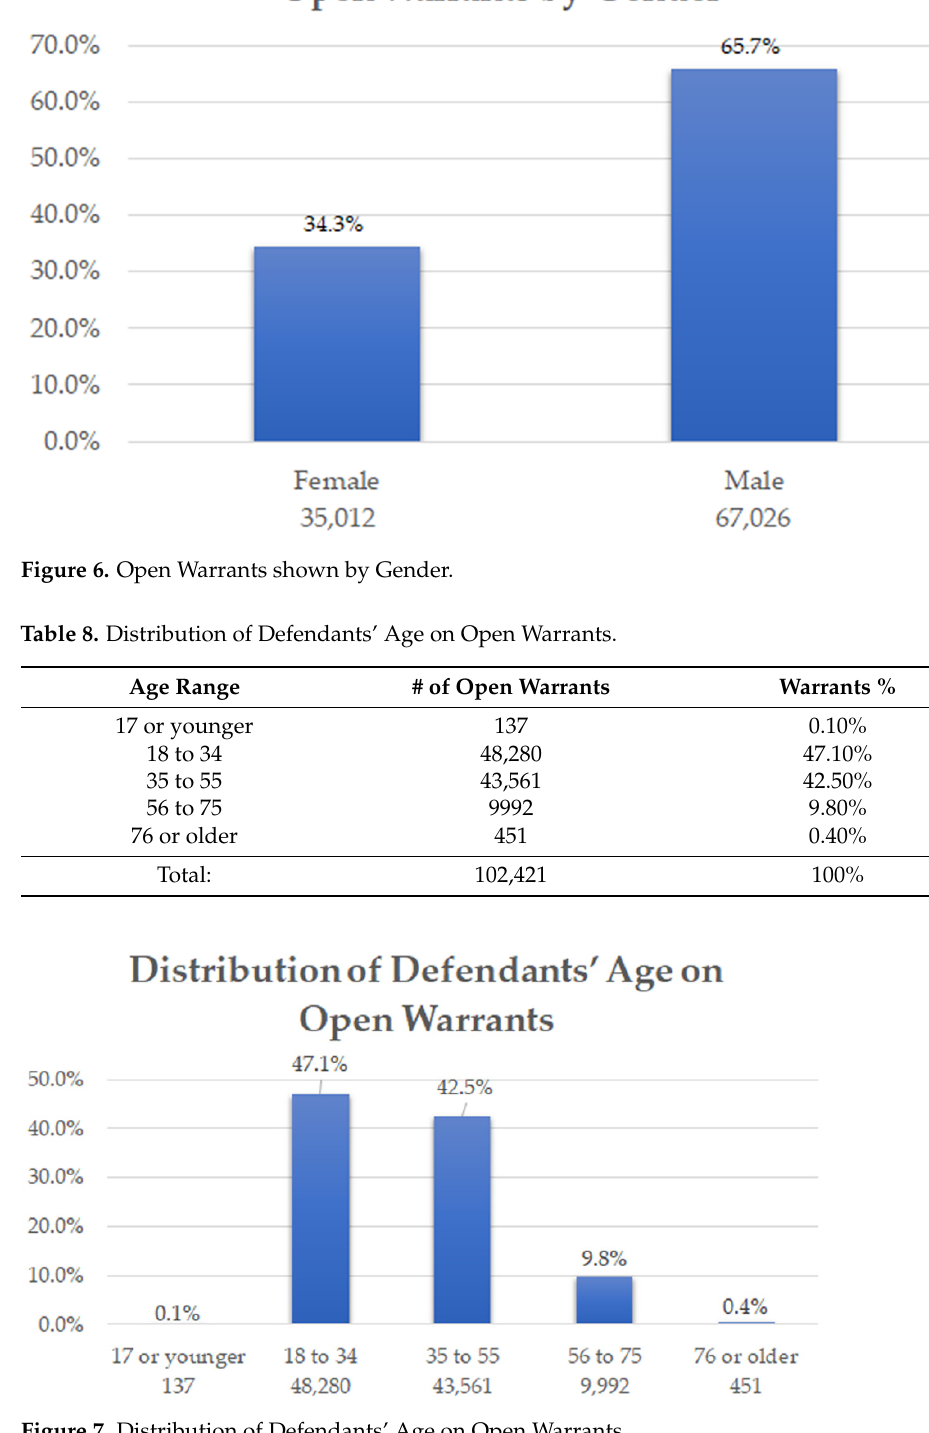
Figure 7. Distribution of Defendants’ Age on Open